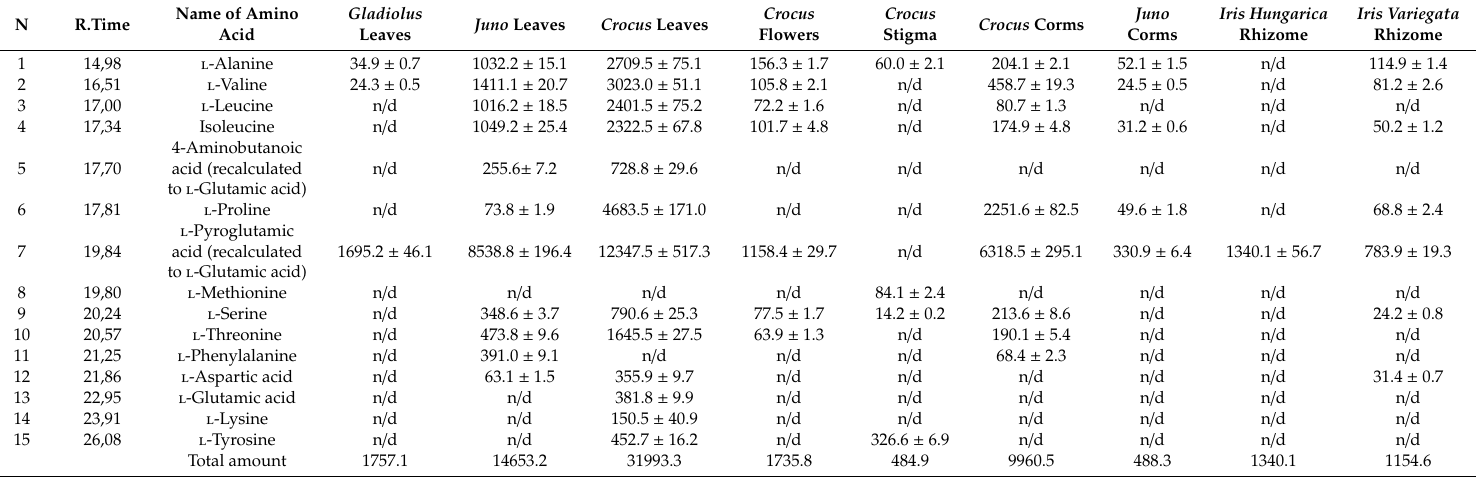
Table 1. The content of free amino acids in Iridaceae dry aqueous plant extracts, µ g /